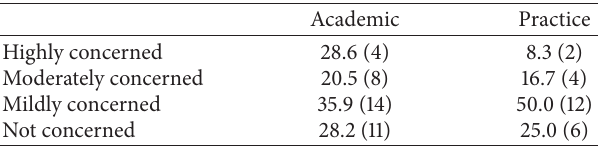
Table 4: Degree of concern over conflicts of interest when collabo- rating with researchers in other organizations, % (𝑁)